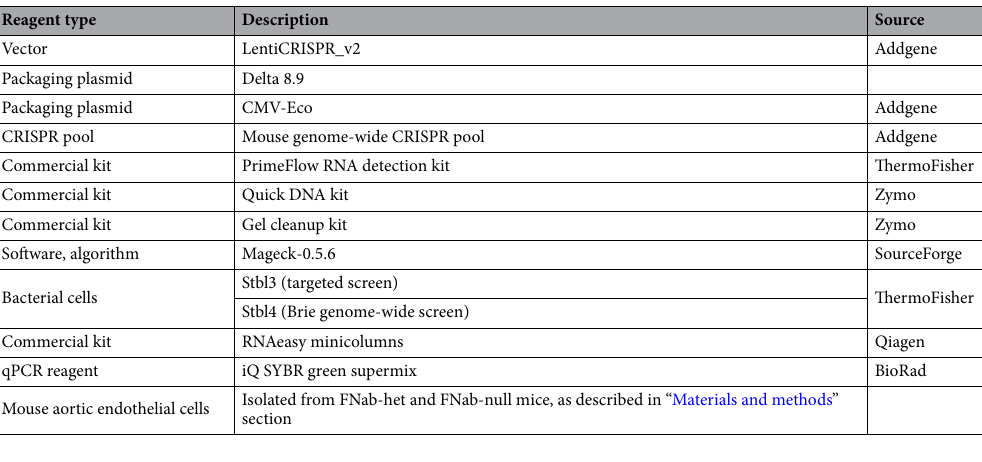
Table 1. Key resources